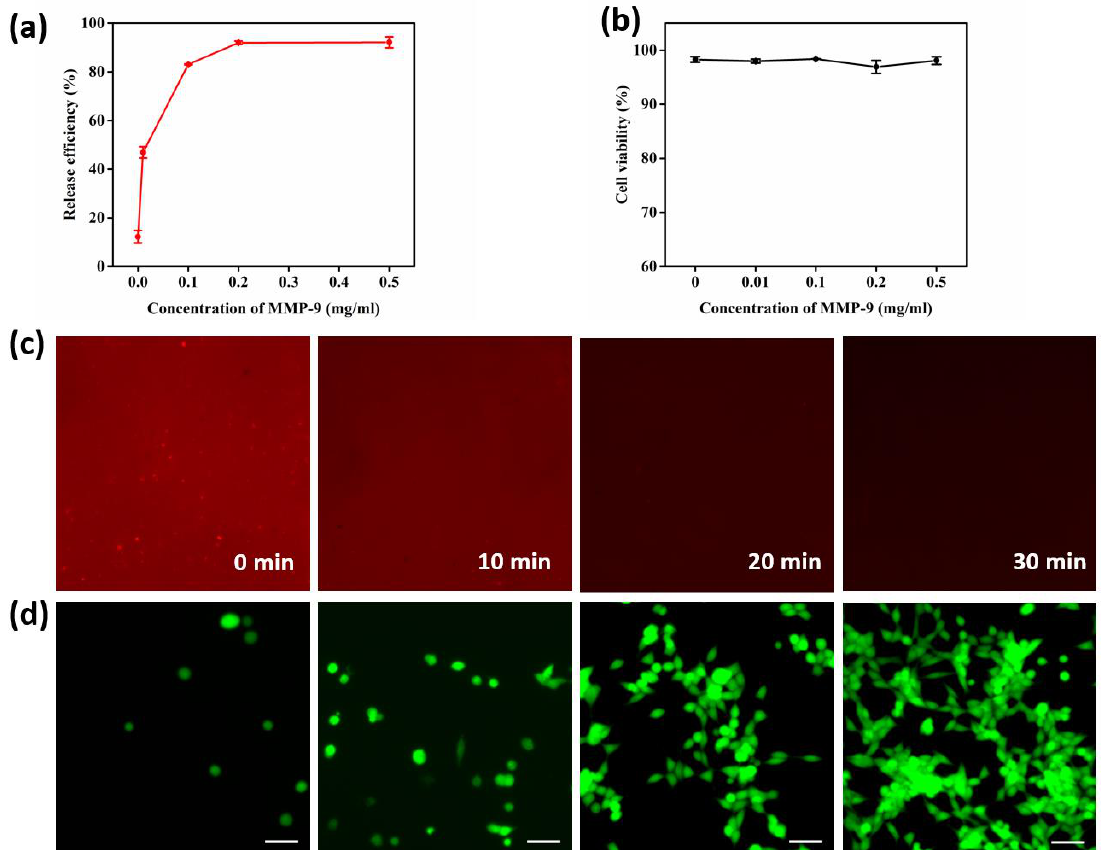
Figure 5. Optimization of MMP-9 concentration and cell release performance. ( a ) Cell release efficiency treated with different concentrations of MMP-9 (0, 0.01, 0.1, 0.2 0.5 mg/mL). ( b ) Cell viability after treatment with different concentrations of MMP-9 for 30 min at 37 °C. ( c ) Fluorescence images of PE-SA-conjugated GNP substrate treated with MMP-9 for 0, 10, 20, and 30 min. ( d ) The viability of released cells using 0.2 mg/mL of MMP-9 solution and re-cultured at times of 0 h, 24 h, 36 h, and 48 h.